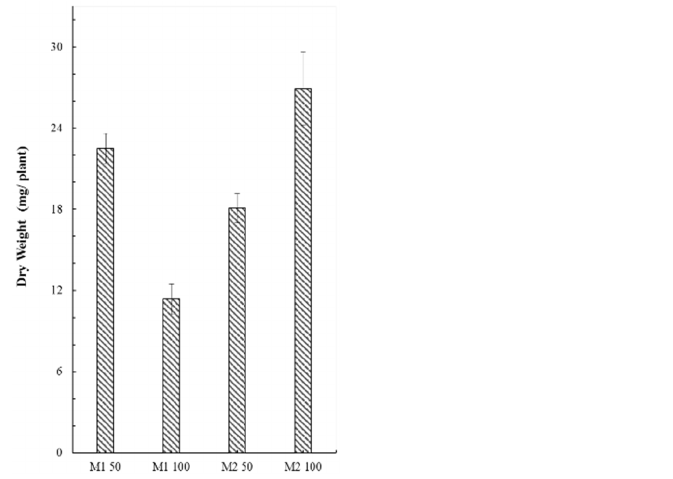
Figure 1. Graph of the substrate mixture (M1 and M2)—fertilizer concentration (50 and 100) effecton dry weight of coriander plants.